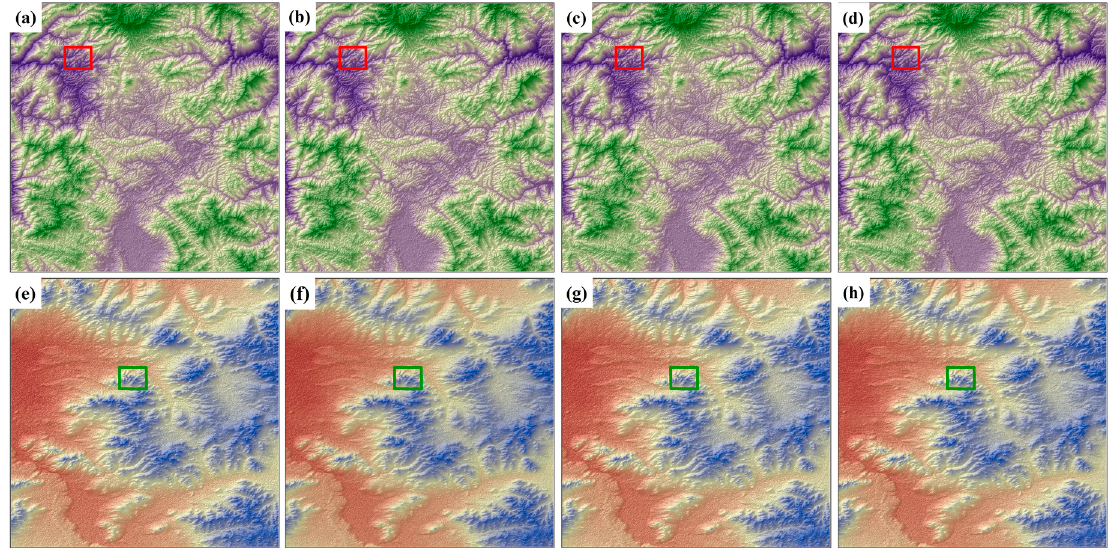
Figure 7. The fused DEMs obtained using the Bior3.7 wavelet, Haar wavelet, BEMD, and N-AMD methods at ( a – d ) site A and ( e – h ) site B. The red and green rectangles are the areas selected in sites A and B that are enlarged in Figure 8.